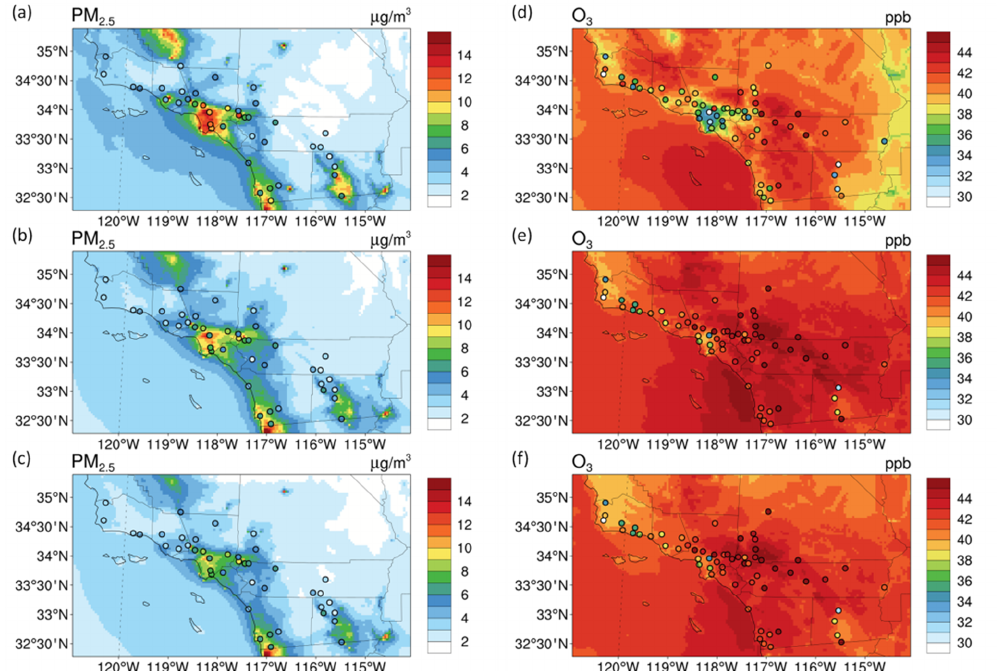
Figure 4. Overlay plots of the simulated (contour) and observed (circles) PM 2 . 5 and MDA8 O 3 concentrations in southern California. Panels (a) – (c) are for PM 2 . 5 and (d) – (f) are for MDA8 O 3 . Panels (a) and (d) are for the pre-lockdown period (18 February to 18 March) under the Base scenario (Pre Base ); (b) and (e) are for the lockdown period (19 March to 23 April) under the Base scenario (Post Base ); (c) and (f) are for the lockdown period under the Lockdown scenario (Post Lockdown ).